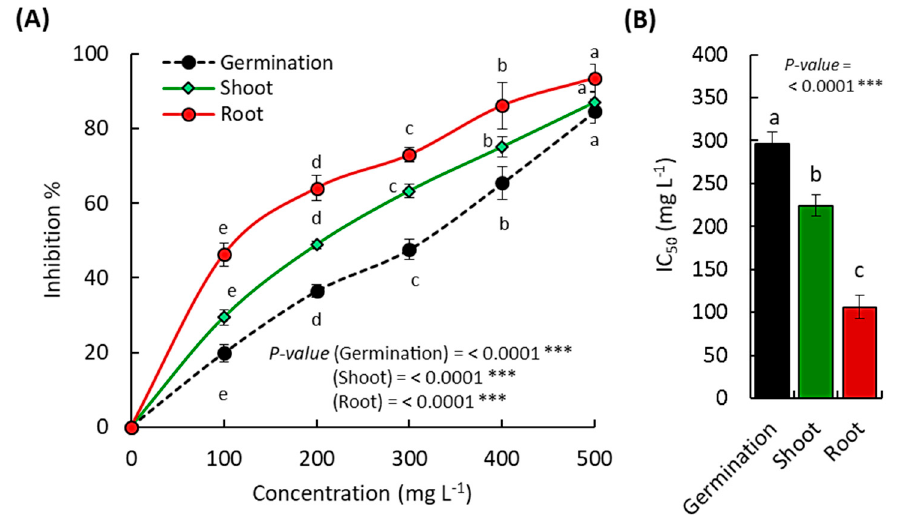
Figure 3. Phytotoxic activity of the EO extracted from the resin of Araucaria heterophylla against the germination and seedling growth of the weed Sonchus oleraceus . ( A ) the inhibitory effect with concentration, and ( B ) the IC 50 value (the concentration of the EO required for 50% inhibition). The bars represented the standard deviation ( n = 3 ). *** p < 0.001.